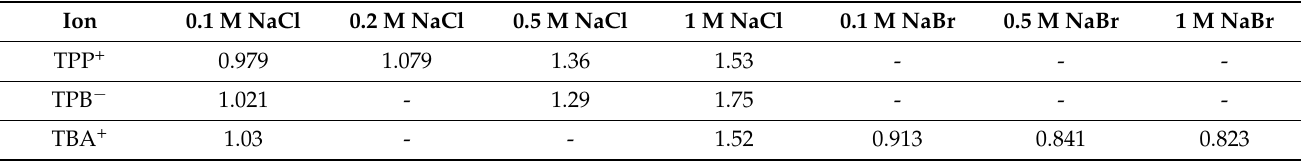
Table A5. The activity coefficients of TBA + , TPP + and TPB − ions in different